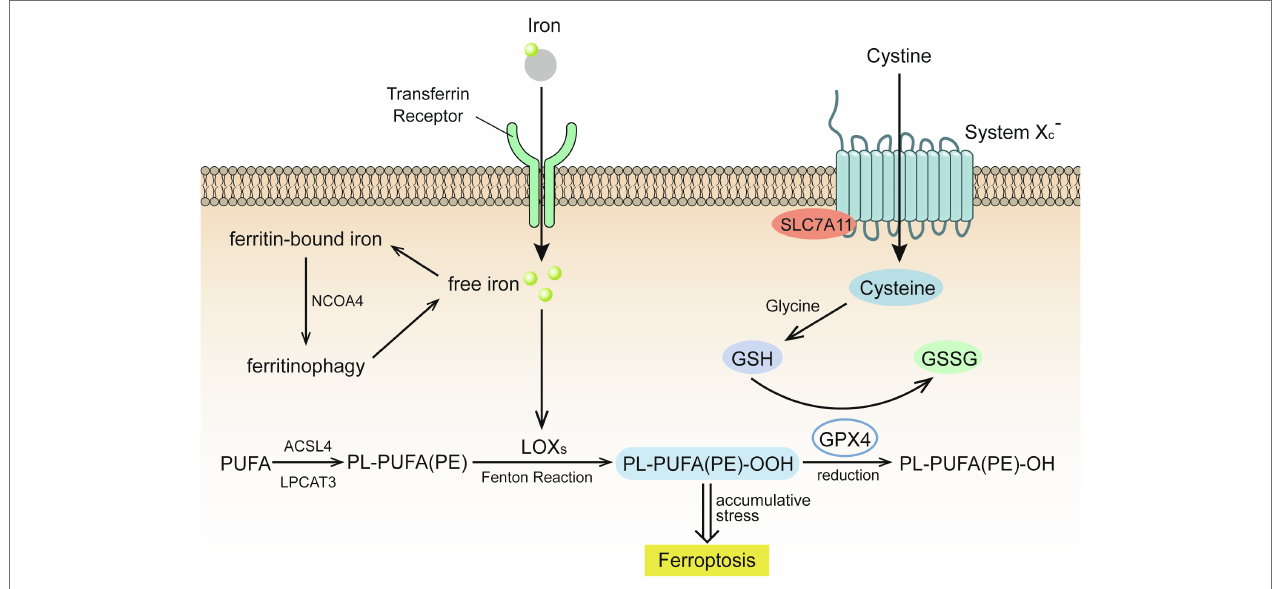
FIGURE 1 | Glutathione (GSH) insufficient promotes the occurrence of ferroptosis (Stockwell et al., 2017). Extracellular cystine is exchanged with glutamate to enter the cell through the cystine/glutamate reverse transport system (system Xc-) and then reverts to cysteine. Under the catalysis of galactosidase and glutathione synthetase, cysteine and glycine co-synthesize glutathione (GSH), which is oxidized by glutathione peroxidase 4 (GPX4) to glutathione disulfide (GSSG), while GPX4 reduces toxic lipid peroxide to nontoxic lipid alcohol. Acyl-CoA synthetase long chain family member 4 (ACSL4) catalyzes the binding of free polyunsaturated fatty acids (PUFAs) to coenzyme A, and lysophosphatidylcholine acyltransferase 3 (LPCAT3) promotes their binding to membrane phospholipids to become PL-PUFAs (PE). Lipoxygenase (LOXs) mediates lipid peroxidation. PL-PUFA (PE) is oxidized to PL-PUFA (PE)-OOH, which becomes a ferroptosis signal. Extracellular iron ions enter the cell from the extracellular environment through transferrin and transferrin receptors, and generate reactive oxygen species (ROS) through the iron- dependent Fenton reaction or activate lipoxygenase to promote lipid peroxidation and promote